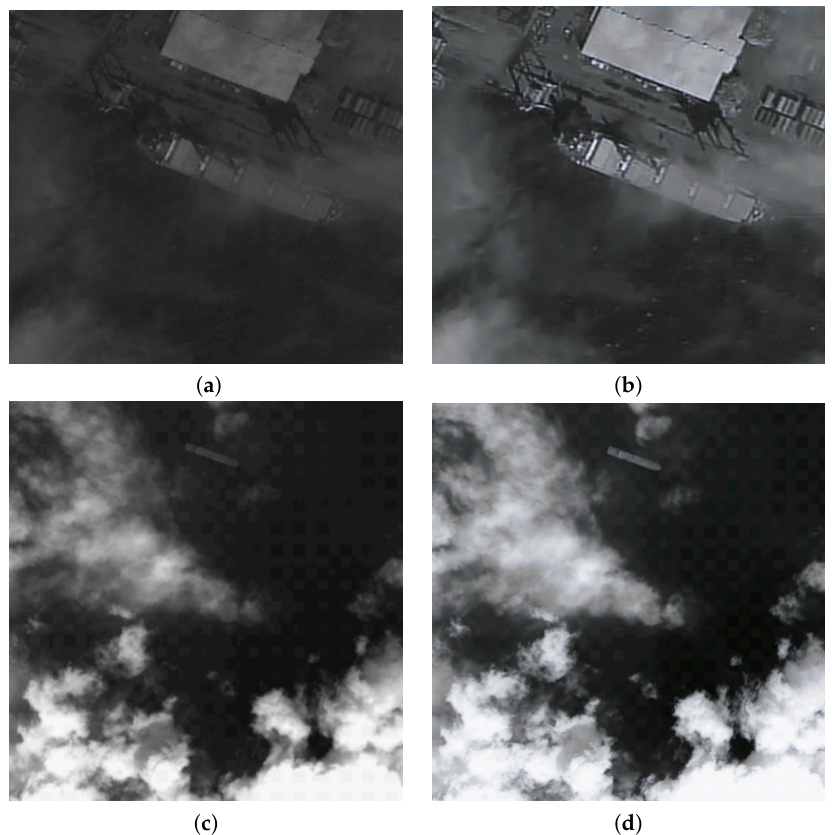
Figure 9. Some output results of the OCIE module. ( a ) is the dark target selected in the Changguang dataset, ( c ) is the cloudy scene, ( b , d ) respectively correspond to the output of these two samples through the OCIE module, in which the target is effectively